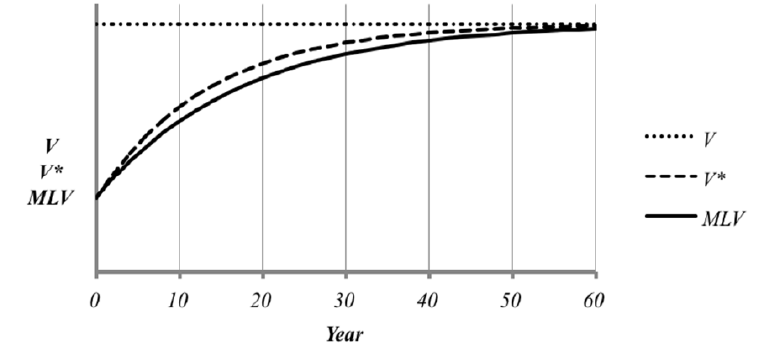
Figure 4. Relationship between V , V *, and MLV and the years. The ratio of the MLV to the bottom value V ∗ referring to the incidence of the built area (22) and the incidence of income (23) ( r = 0.06 ; r L = 0.02 ; n = 30) is graphically rendered by Figure 5.